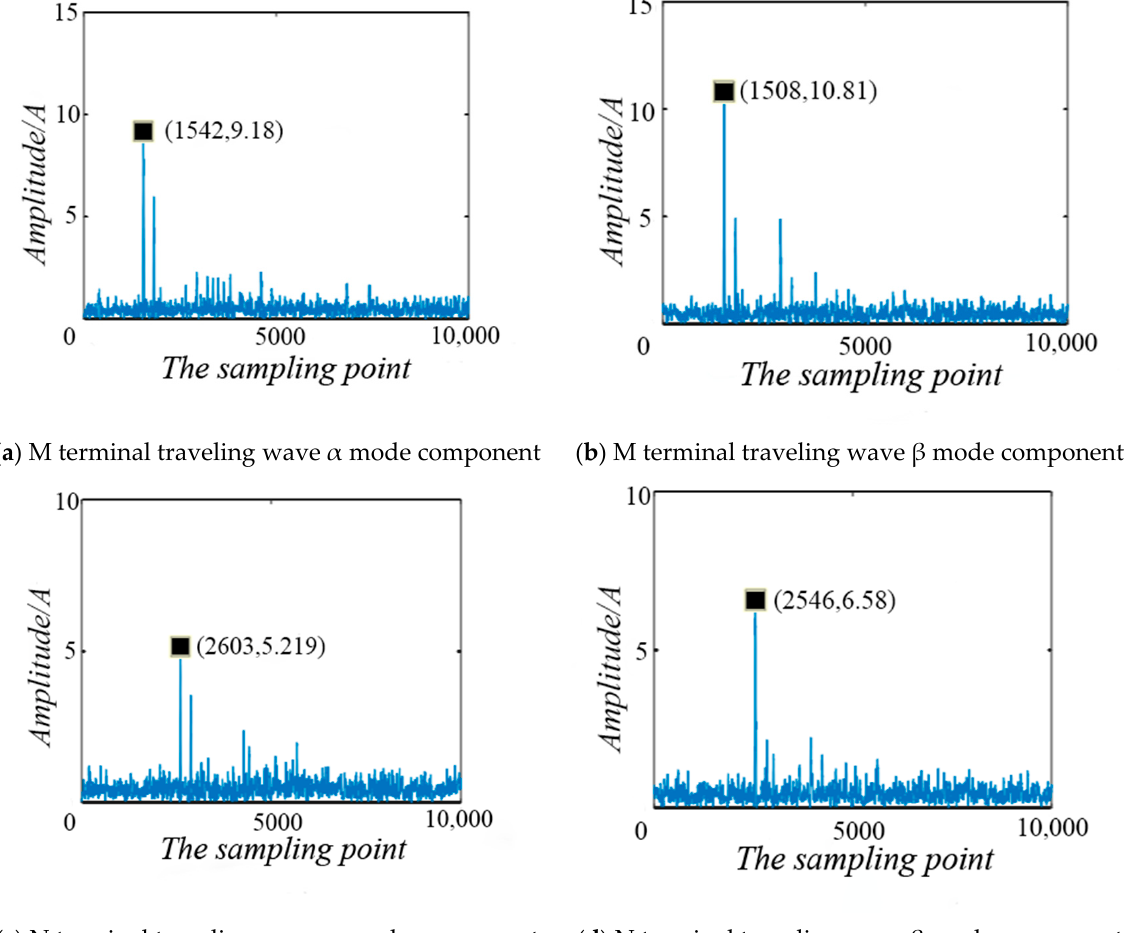
Figure 2. Time of arrival of the fault traveling wave mode component.